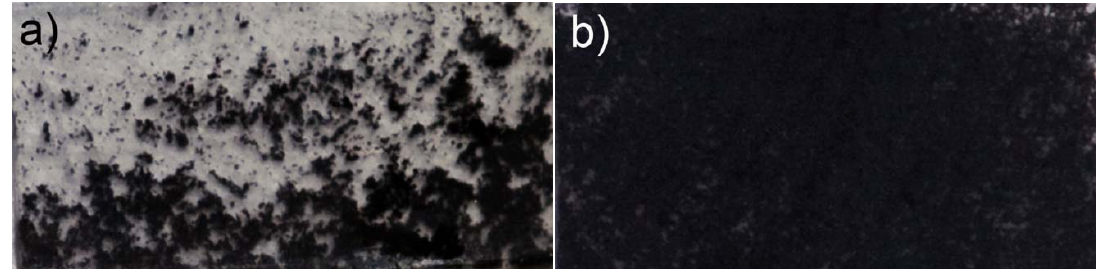
Figure 5. Digital photograph images of a cross-section of epoxy composite